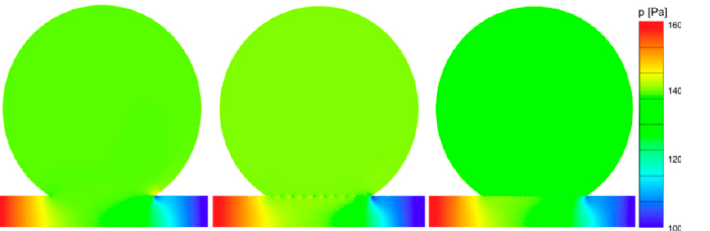
Figure 11. Pressure contour at the mid plane of the UA ( left ), RS ( center ), and FD ( right ) at late diastole.